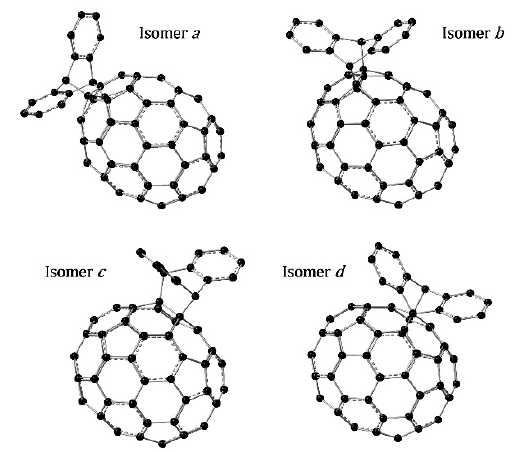
Figure 3. Optimized molecular structures for the four possible regioisomers of AC 70 MA. For AIC 60 BA (anthracene indene C 60 bis adduct), of a total of 29 possible isomers, 14 regioisomers were optimized using M06-2X/6-31+G(d); the optimized molecular struc-